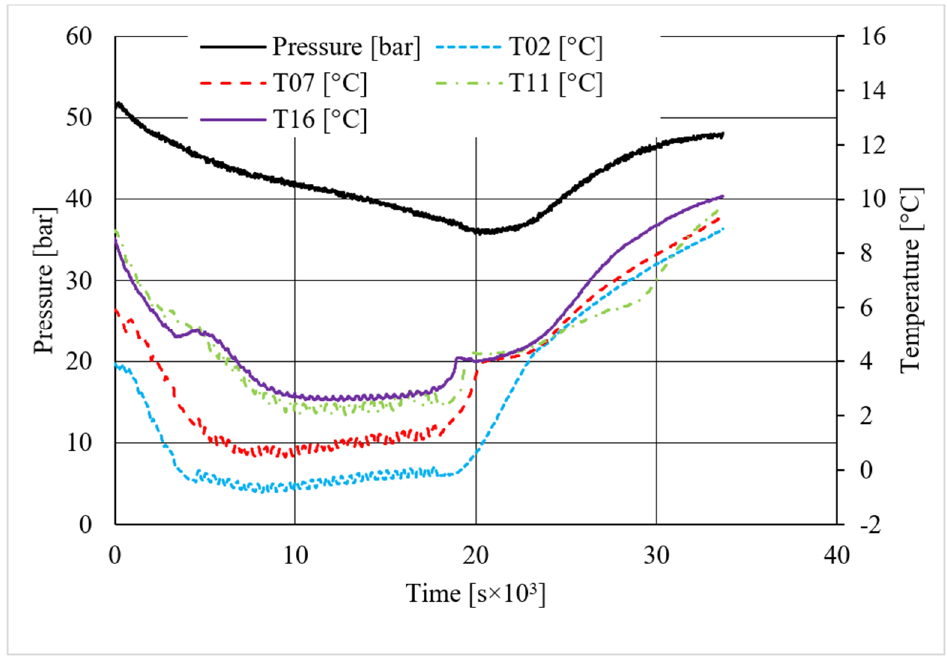
Figure 7. Pressure and temperature trends over time, measured for methane hydrate formation in the presence of 4.23 wt.% CuSn12 powder.